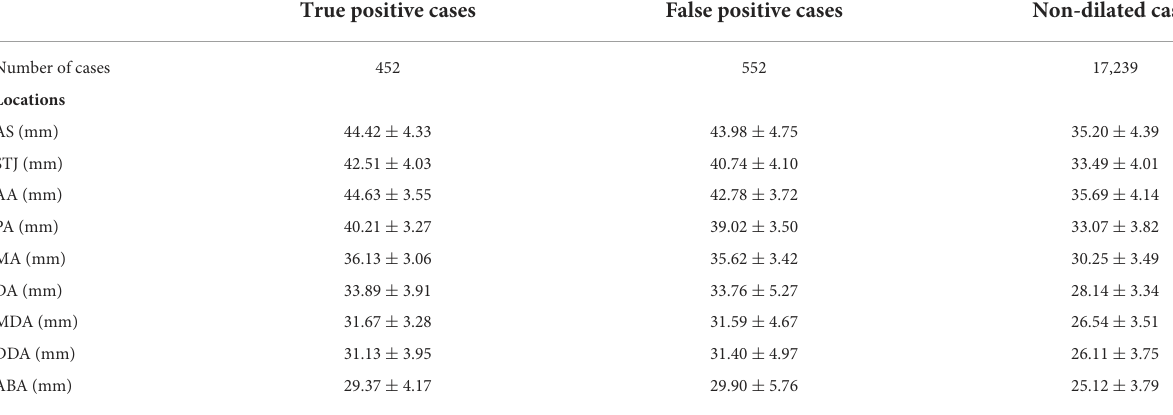
TABLE 3 Mean diameters per location in the true positive, false positive and non-dilated cohorts. True positive cases